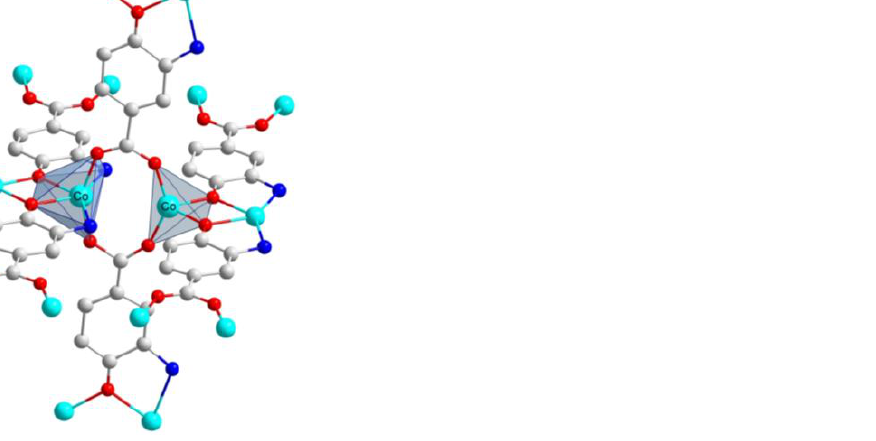
Figure 1. Excerpt of the crystal structure of Co-MOF showing the trigonal prismatic and tetrahedral the coordination polyhedral involved in the disorder of the structure.